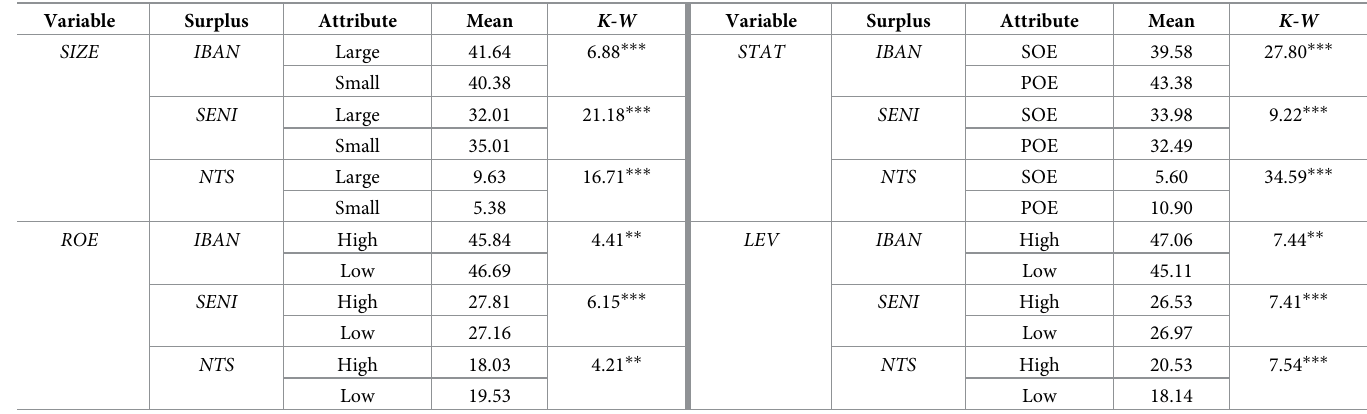
*** and ** represent significance levels at 1% and 5%. When the categorical variable is continuous, grouping is performed according to the mean of the variable. IBAN , SENI , and NTS denote the surplus occupied by IBs and executives and the net surplus, respectively. K–W test is the abbreviation of the Kruskal–Wallis